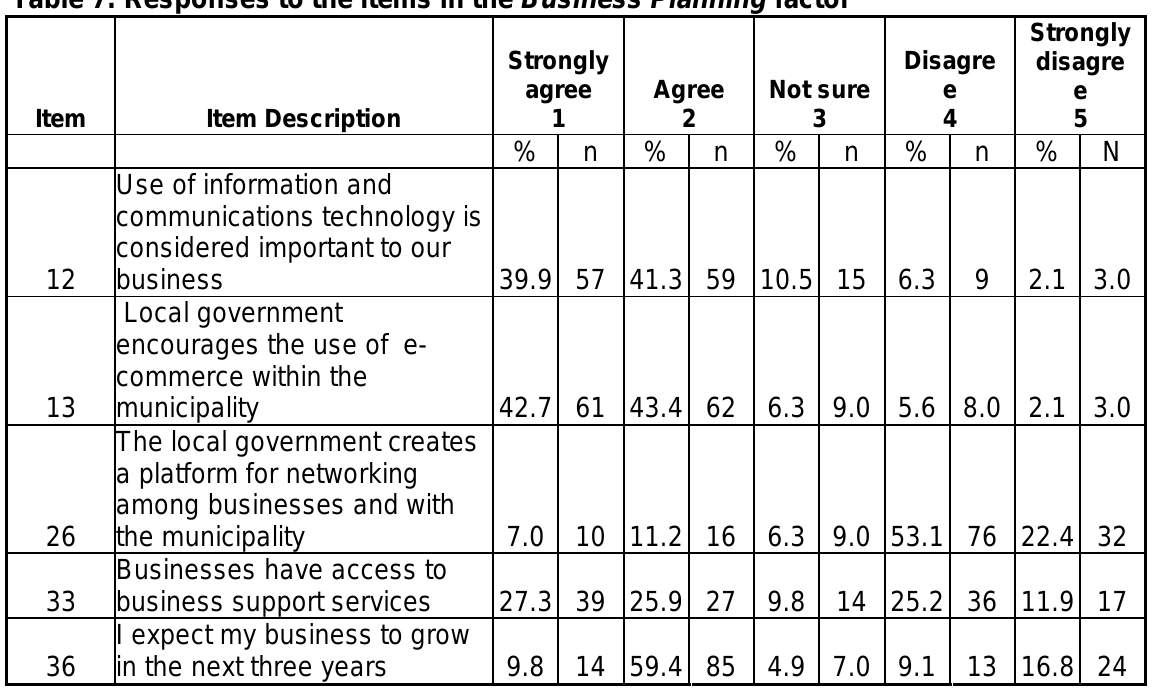
Table 7: Responses to the items in the Business Planning factor